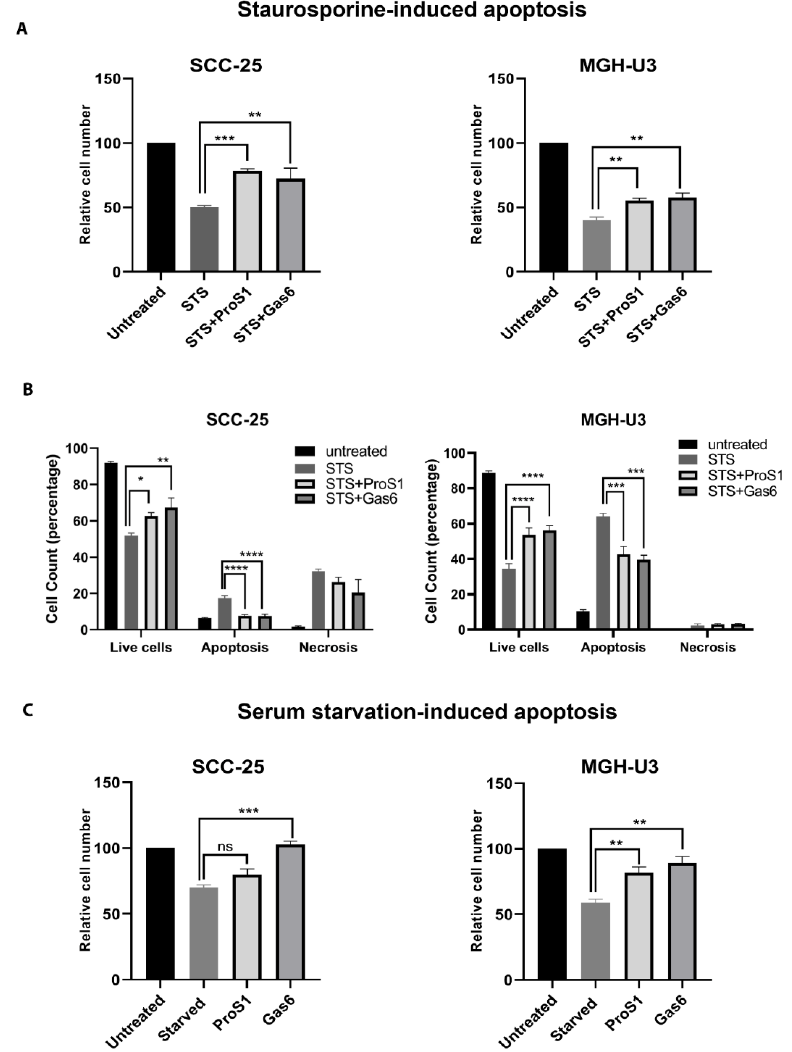
Figure 5. Effect of ProS1 and Gas6 on cancer cells undergoing apoptosis and role of TAM receptor expression profile in mediating these effects. MTS cell viability assay of SCC-25 (express Tyro3 and Axl) and MGH-U3 (express Tyro3 only) cells incubated for 20 h in the presence of staurosporine (0.1 µM) (short term) ( A ) or in serum-free medium for 20 days (long term) ( C ), with co-incubation with Gas6 or ProS1 added 1 h previously. ( B ) Flow cytometry results showing percentage of SCC-25 and MGH-U3 cells undergoing apoptosis (Annexin V-FITC/PI double-stained) by 20 h incubation with staurosporine (0.1 µM), with co-incubation with TAM ligands added 1 h previously. Graphs show proportions (%) of healthy, apoptotic and necrotic cells. Data are mean±SEM, and underwent ANOVA with Tukey’s multiple comparison post-hoc analysis; **** p < 0.0001, *** p < 0.001, ** p < 0.01, * p < 0.05 versus indicated control (no treatment or staurosporine-treated) or for comparisons indicated by lines (n = three experiments).